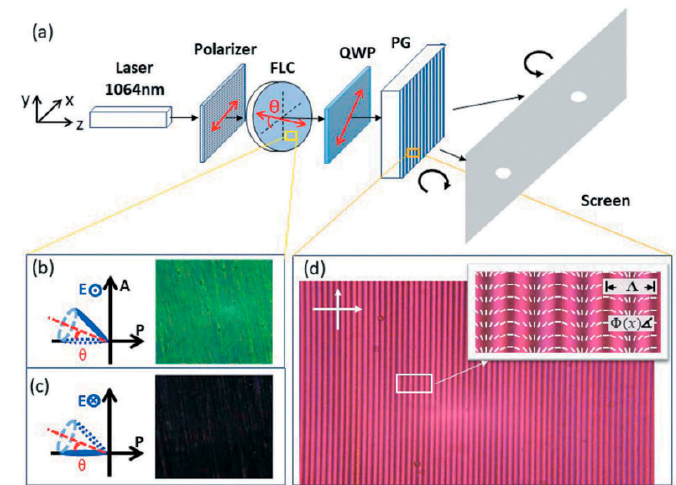
Figure 18. Schematic illustration of ESH as a polarization shutter in a beam steering set up. ( a ) The optical setup with FLC phase shutter. ( b ) and ( c ) are FLC textures (right) under two voltage polarities recorded by polarized microscope with polarizer and analyzer illustrated (left), the helical axis is shifted angle θ from polarizer. ( d ) Texture of polarization grating [42].